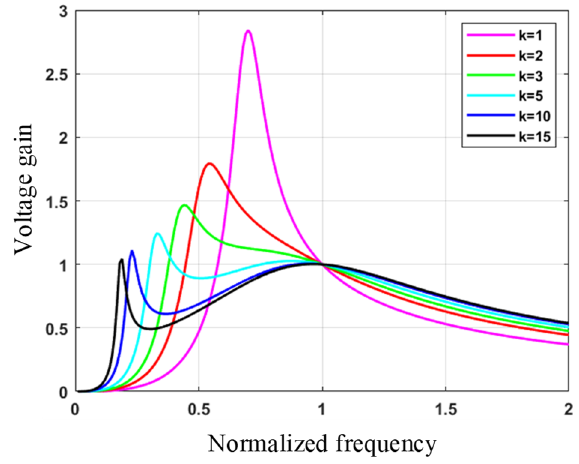
Figure 6. Voltage gain at different k values ( Q = 0.5).